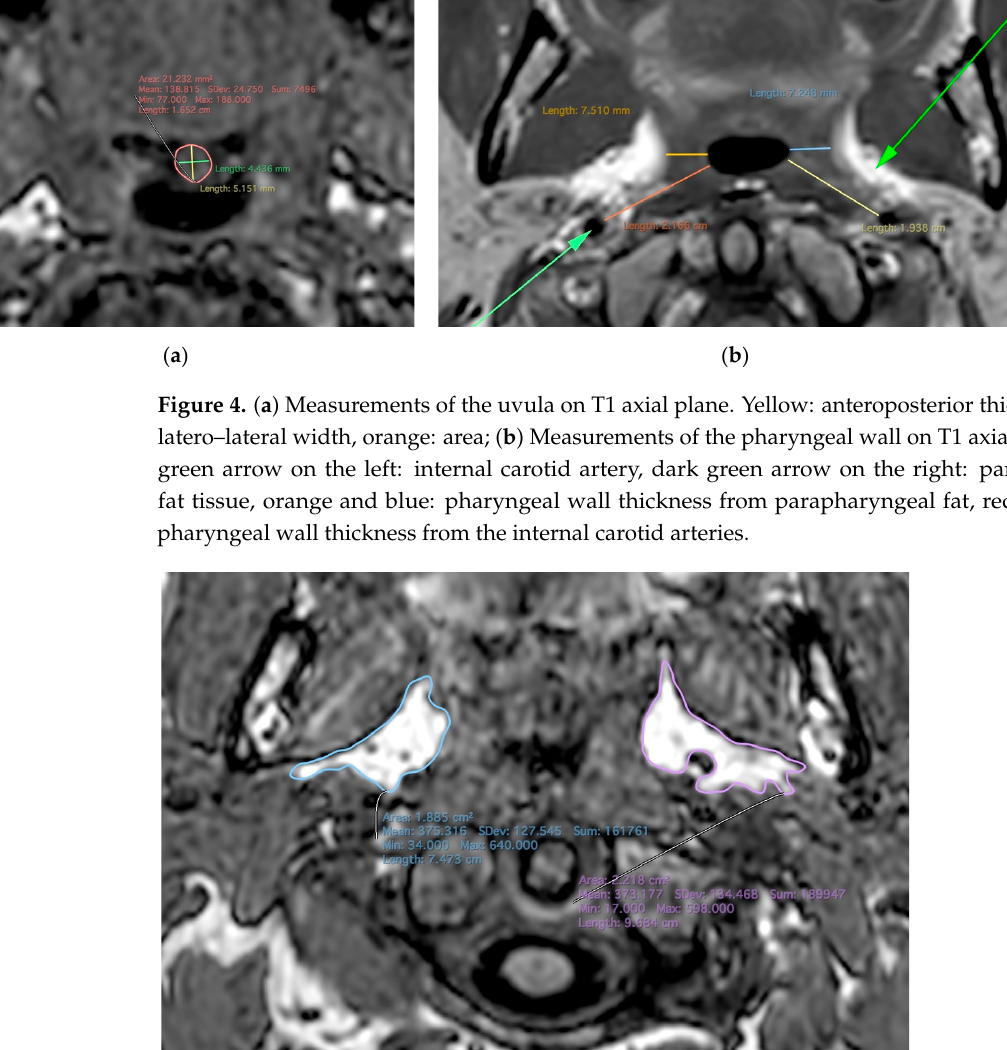
Figure 5. Area of the parapharyngeal fat tissue. Blue: right area, purple: left